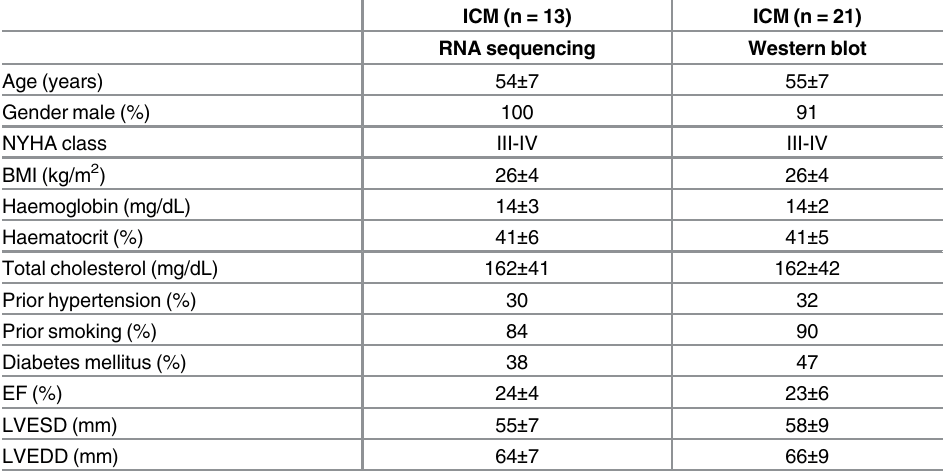
Table 1. Clinical characteristics of ischemic cardiomyopathy (ICM) patients.